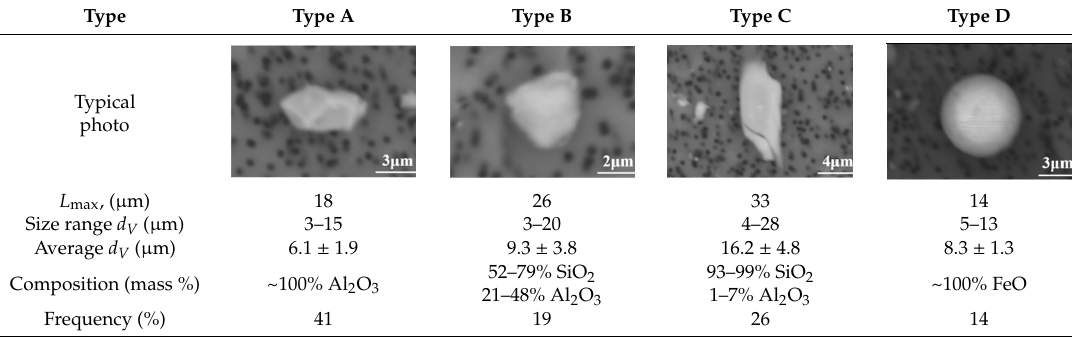
Table 4. Classification of inclusions in FeB alloys.